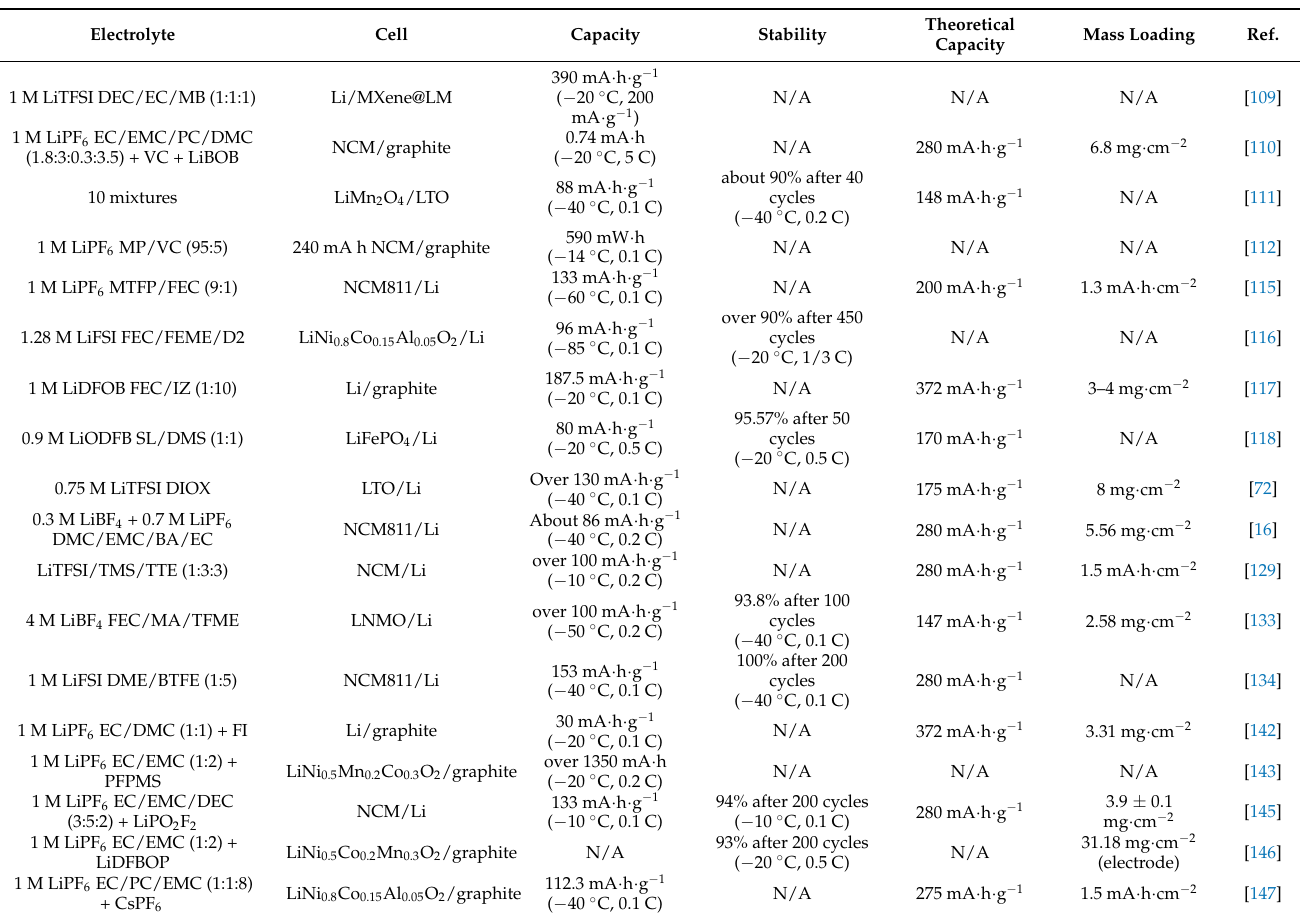
Table 3. Summary of the low-temperature electrochemical properties of recently studied